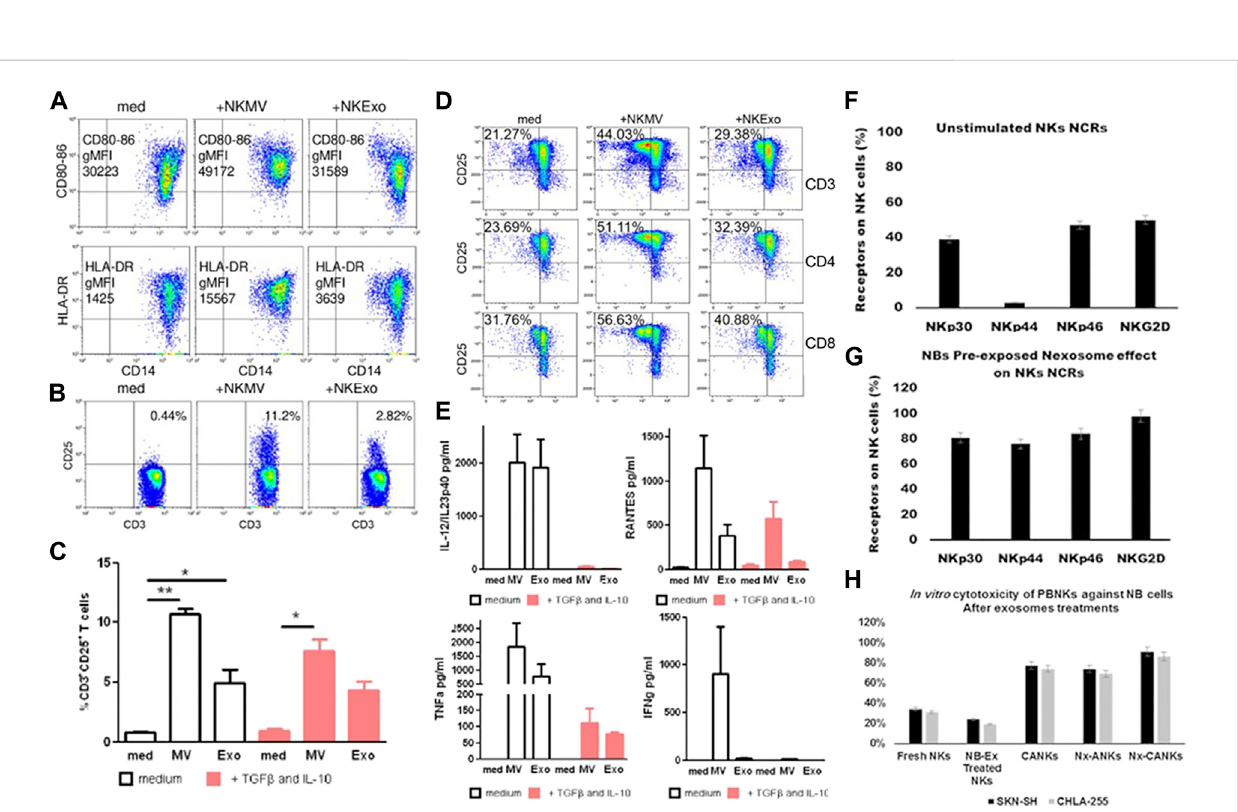
FIGURE 3 (A) NEVs activate monocytes. Flow cytometry analysis of CD80 – CD86 geo mean fl uorescence intensity (gMFI) of gated CD14 + cells in PBMCs cultured in the presence or absence of NEVs, and/or lipopolysacharide (LPS) for 24 h. Upper panels: Representative dot plots showing CD80 – CD86 expression in the presence of NEVs, lower panel: Flow cytometry of human leukocyte antigen DR isotype (HLA-DR) gMFI of CD14 + gated monocytes(Federicietal.,2020). (B) FlowcytometryanalysisofCD25expressionbyCD3 + gatedTcellsinPBMCsevaluatedafter72 hofculturewith NEVs (Federici et al., 2020). (C) The graph shows the results obtained with PBMCs of different healthy donors ( n = 3), in the presence or absence of transforminggrowth factor beta (TGF β )/interleukin (IL)-10 (10 ng/ml each) (Federicietal.,2020). (D) NEVs affect theinteraction betweenmonocytes and T cells. Flow cytometry analysis of 72 h proliferation and CD25 expression by CD3, CD4, and CD8 T cells cultured in the presence of monocytes (medium), monocytes preconditioned with NEVs (Federici et al., 2020). (E) NEVs induce the release of cytokines by PBMCs. Cytometric bead array- measuredcytokineproductionof72 hPBMCscultured(Federicietal.,2020). (F – H) ActivationofrestingNKcellsbyNEVsaffectstheexpressionofnatural cytotoxicity receptors on their surface and tumor-killing viability (Shoae-Hassani et al., 2017). (F) NK cells were stained with speci fi c NCRs monoclonal antibodies, a resting NK cell expresses different levels of NCRs. (G) The NEVs induce the expression of NCRs especially NKp44 similar to cytokine- activated NK. (H) In vitro cytotoxicity of peripheral blood natural killer cells against neuroblastoma (NB) cells. NEVs strongly stimulated NK activity in